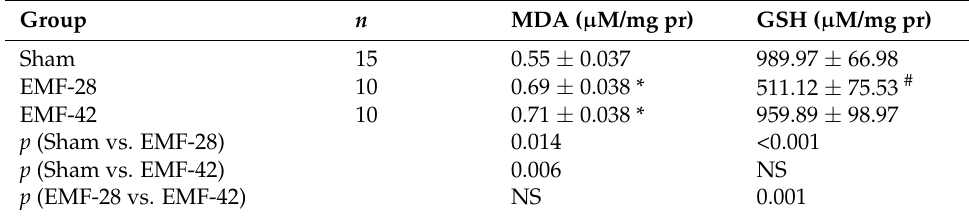
Table 3. MDA and GSH levels of male rat pups’ testis (mean ± SEM).